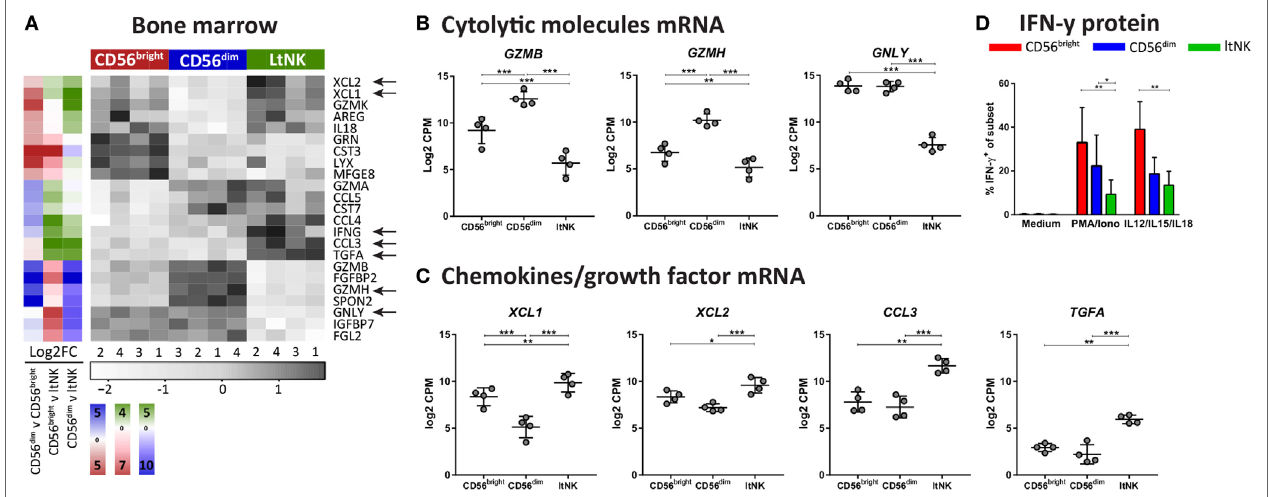
FigUre 4 | Effector molecule profile of ltNK cells highlights low killing capacity. (a) Heatmap depicts normalized mRNA expression levels of genes, which encode effector molecules and have the highest or lowest expression in 1 of the 3 bone marrow (BM) derived natural killer (NK) cell subsets [false discovery rate (FDR) < 0.05]. The column side bars represent the log2-fold change (FC) of gene expression levels in one NK cell subset versus another. The color indicates in which NK cell population the gene is expressed at the highest level (green = ltNK, red = CD56 bright , blue = CD56 dim ). (B,c) Normalized mRNA expression values of differentially expressed (B) cytolytic molecules (granzyme B, granzyme H, and granulysin) and (c) chemokines (XCL1, XCL2, CCL3) and the growth factor TGF α . CPM, counts per million of uniquely mapped reads. *FDR < 0.05, **FDR < 0.01, ***FDR < 0.001. FDR, false discovery rate. (D) Intracellular IFN- γ expression of CD56 bright , CD56 dim , and ltNK cells. BM mononuclear cells ( n = 7) were stimulated for 4 h with PMA/ionomycin or the combination of IL12, IL15, and IL18. After 1 h, Golgistop was added to the culture. * P < 0.05, ** P < 0.01, by one-way ANOVA. Mean ± SD are shown in (B–D)